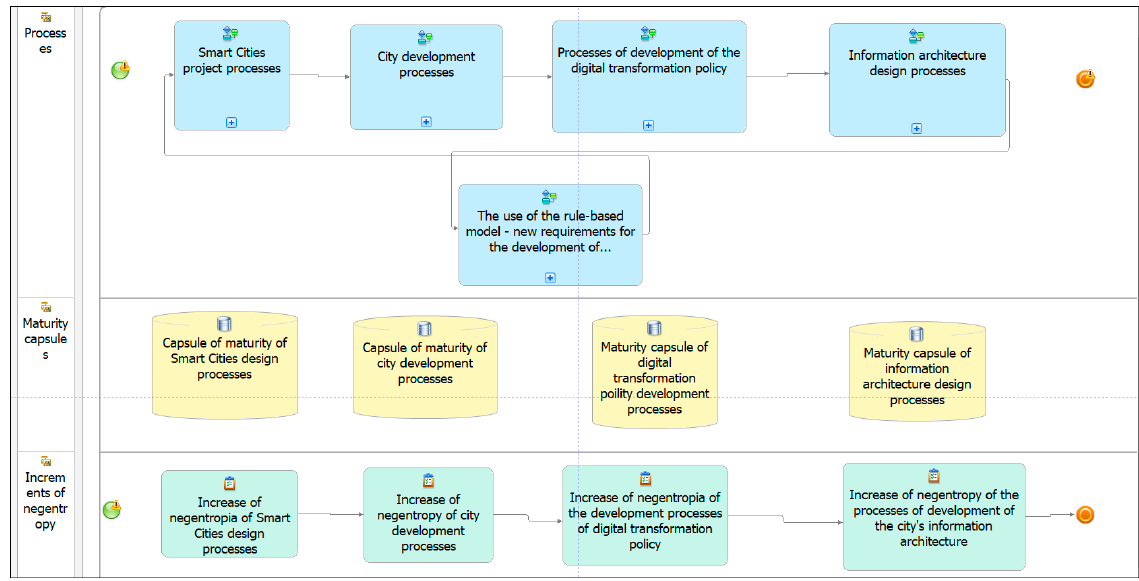
Figure 1. Layers of the negentropy flow model of the digital transformation processes project.